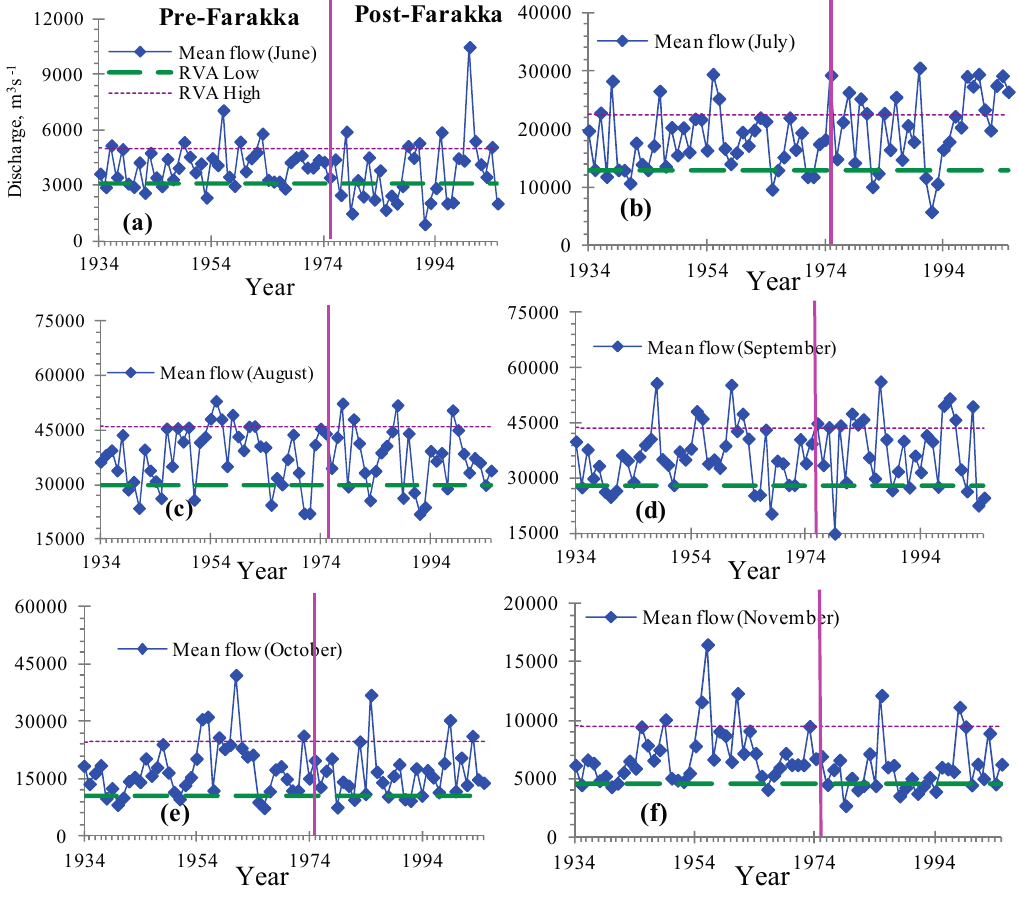
Figure 3. Monthly mean flow for wet months of June ( a ), July ( b ), August ( c ), September ( d ), October ( e ) and November ( f ) in the pre- and post-Farakka period and a comparison with the threshold